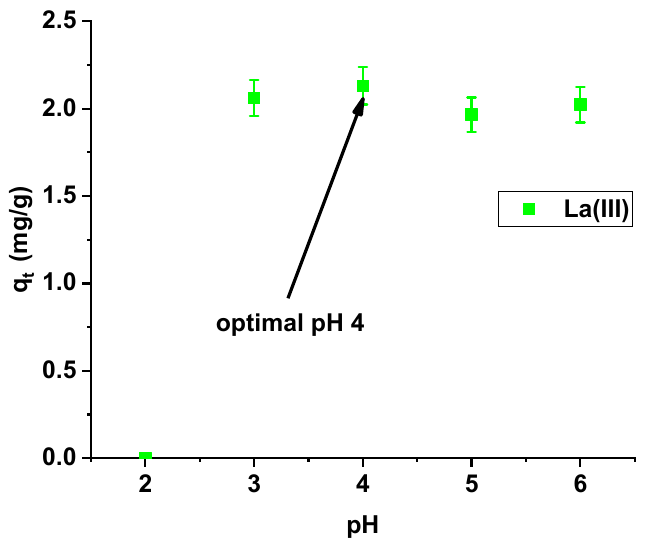
Figure 6. Effect of pH on lanthanum(III) adsorption on X np (c 0 = 10 mg/dm 3 ; m = 0.1 g; t = 24 h).